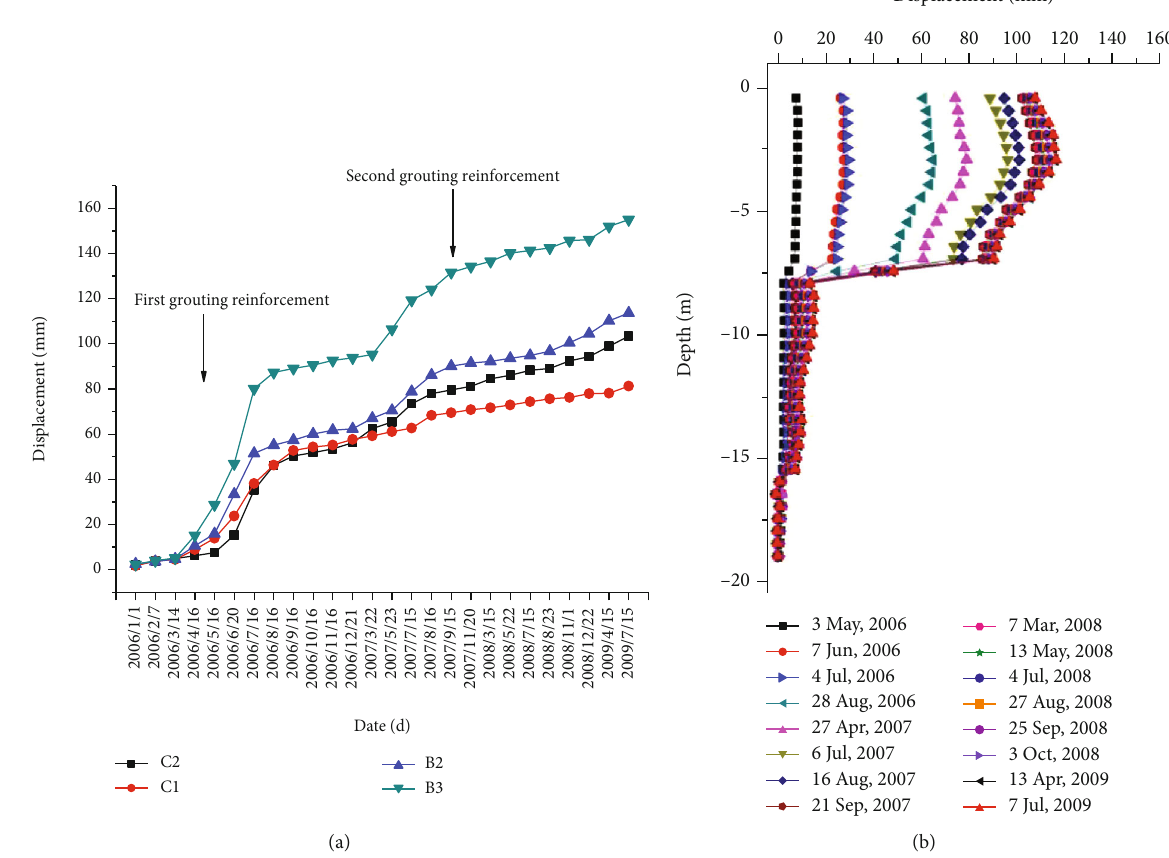
Figure 10: Final monitoring data: (a) surface displacement data; (b) deep displacement of the slope. Table 4: Parameters of steel-tube and cement composite